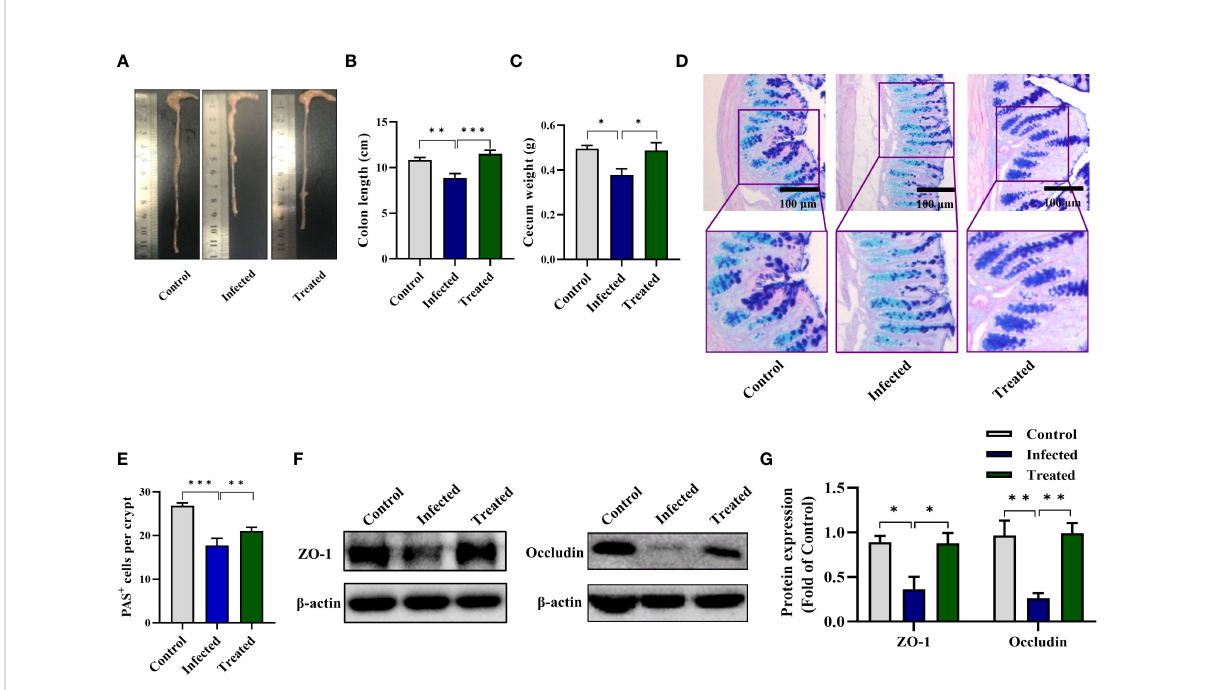
FIGURE 8 MBZ attenuated colonic histopathology in mice post the protoscoleces of Echinococcus granulosus infection. The protective effect of MBZ on colonic histopathology were evaluated by various parameters. (A) The representative images of colons. (B) The colon length (n = 6). (C) The cecum weight. (D) Intestinal goblet cells and mucus were shown by PAS staining (scale bar: 100 m m). (E) Number of PAS + cells (goblet cells) per crypt. (F, G) Protein expression levels of ZO-1 and occludin in the colon (n = 4 - 6). * P < 0.05, ** P < 0.01, *** P < 0.001.